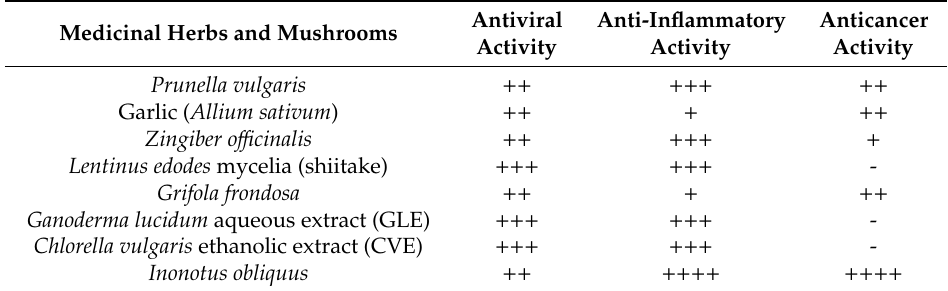
Table 2. The list of introduced medicinal herbs and mushrooms. ( + stands for the level activity, representing mild, moderate, severe and very severe